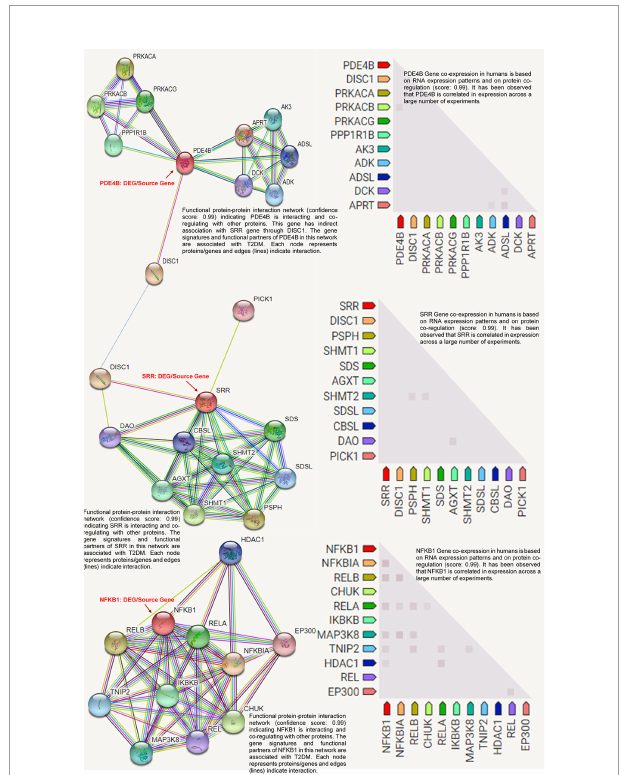
FIGURE 6 | Protein product co-expression network analysis using the STRING database, version 11.0. The protein network was calculated based on the neighborhood score with higher con fi dence (con fi dence score > 0.99). Nodes represent proteins and edges indicate interactions. The co-expression scores based on RNA expression patterns and protein co-regulation were studied and annotated keywords (FDR < 0.05) were